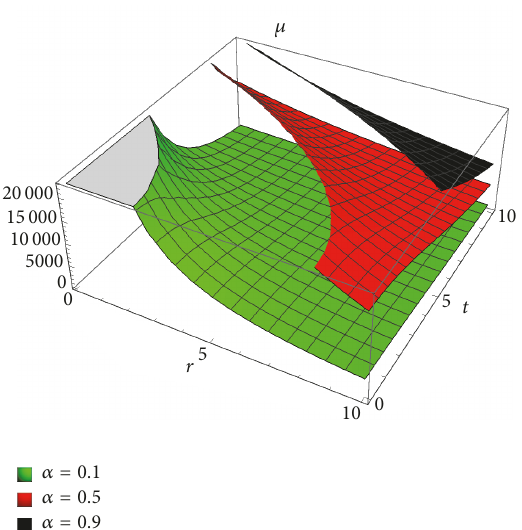
Figure 1: Plot of density along 𝑟 and 𝑡 for 𝑘 = 2.5 and the different values of 𝛼 .